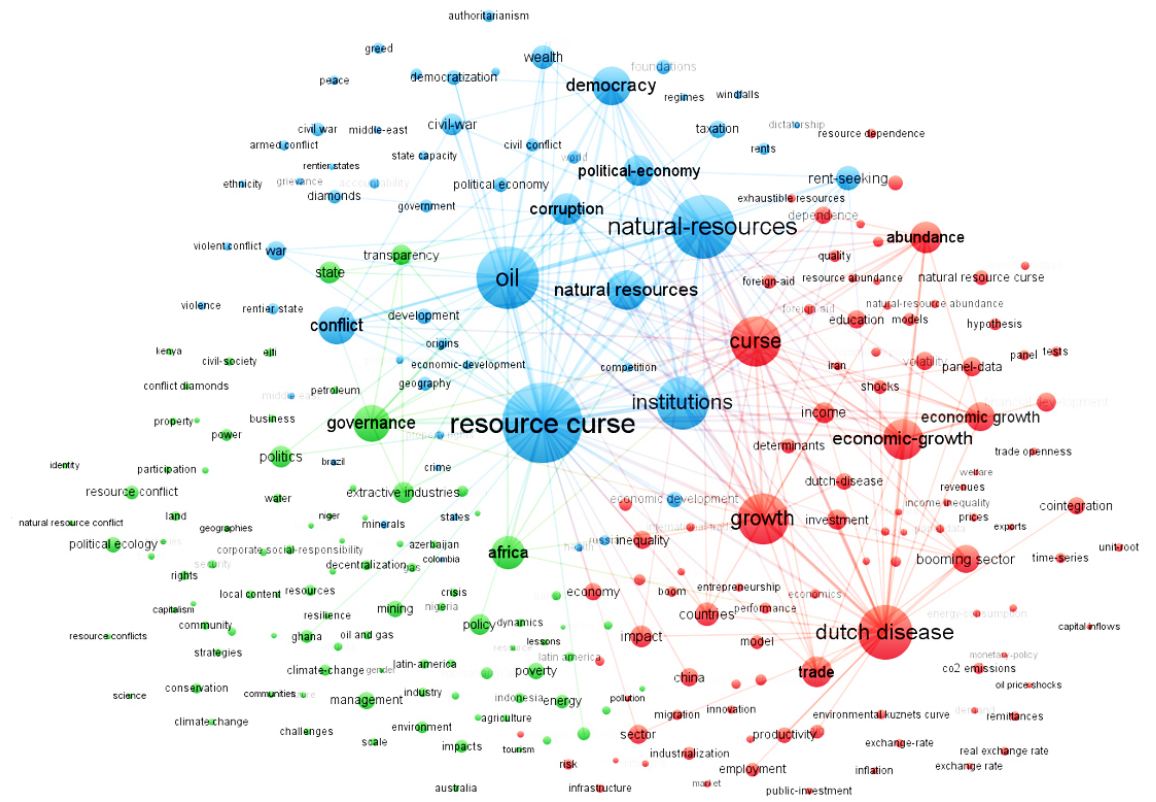
Figure 16. The keyword co–occurrence frequency colorful map (using VOSviewer).